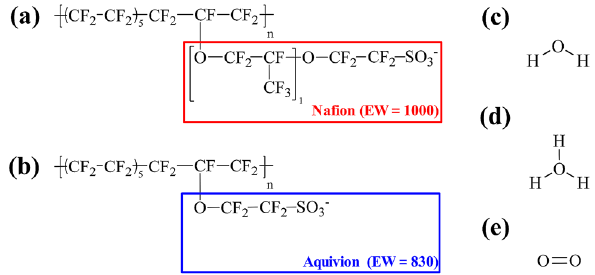
Figure 1. Chemical structures of PFSA component at ( a ) ionized Nafion (EW = 1000), ( b ) ionized Aquivion (EW = 830), and ( c ) water, ( d ) hydronium ion, and ( e ) O 2 molecules.